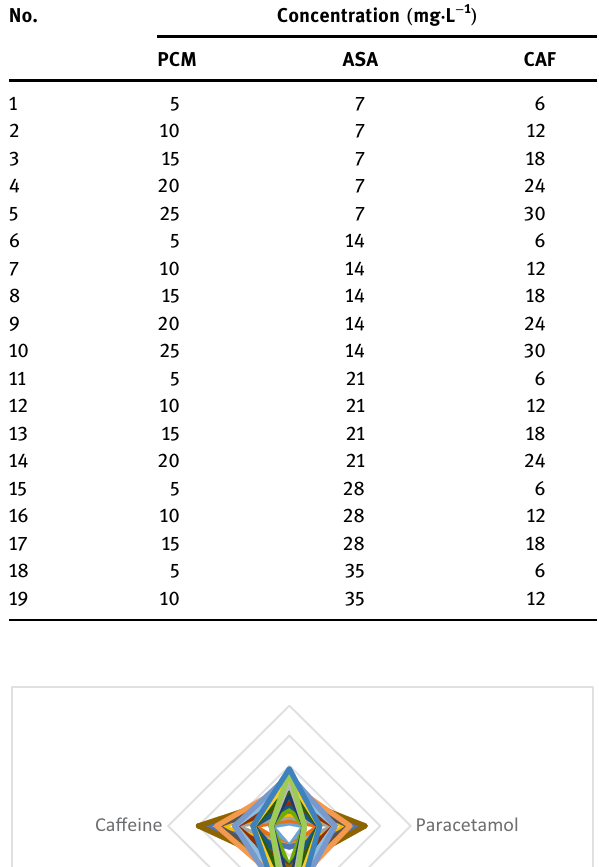
Table 1: Concentration set for ASA, PCM, CAF No.